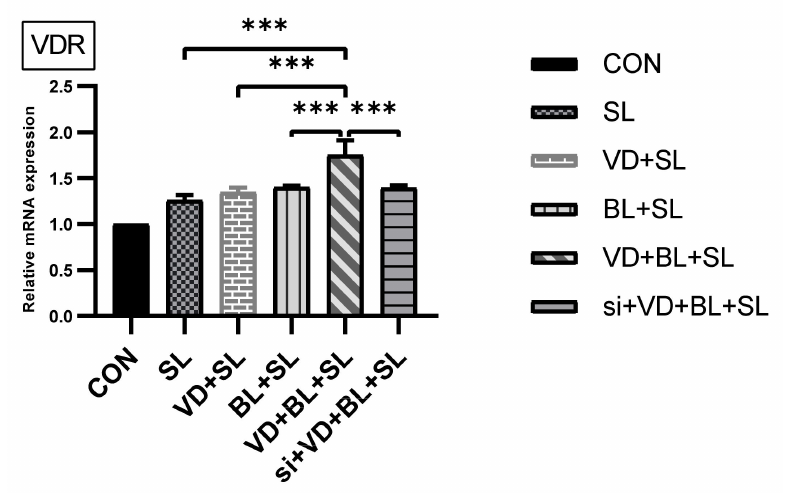
Figure 4. The synergistic effects of active vitamin D and Bifidobacterium longum on VDR mRNA expression in Salmonella -infected SW480 cells. SW480 cells were uninfected (CON) or infected by S. typhimurium wild-type strain SL1344 (SL) in a constant concentration, with and without treatment of Bifidobacterium longum (BL), 1,25D3 (VD) or combination of both (VD+BL). Transfection of SW480 cells with VDR siRNA (si) was performed to knockdown VDR Total RNA extracted from SW480 cells was prepared for analyzing the levels of VDR mRNA by real-time quantitative PCR. The results of mRNA levels were depicted as means ± SEM of at least three independent experiments. *** p <